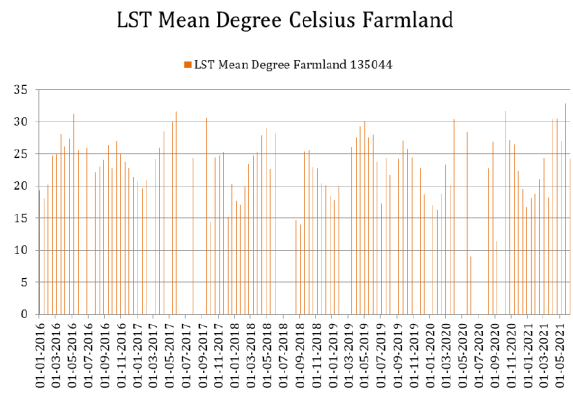
Fig. 8: LST Mean Degree Celsius for Farmland region from